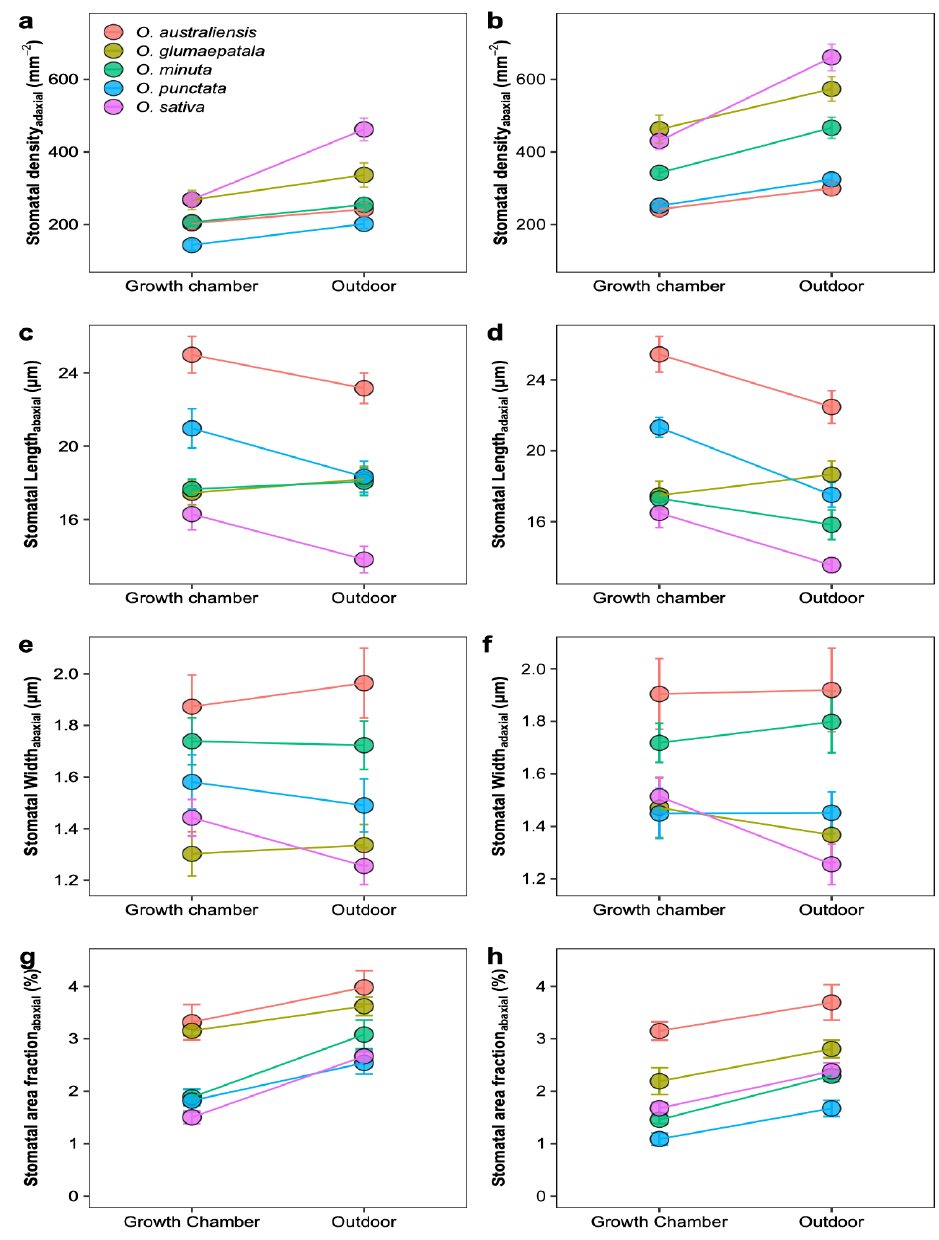
Figure 3. Plastic response of stomatal traits to growth environments for five Oryza species. Mean ± SE values for stomatal density ( a , b ), stomatal pore length ( c , d ), guard cell width ( e , f ), and stomatal area fraction ( g , h ). All the traits were estimated on adaxial ( a , c , e , g ) and abaxial ( b , d , f , h ) surfaces separately. All traits showed significant variation across species ( p < 0.01, ANOVA); n = 5 individual plants.